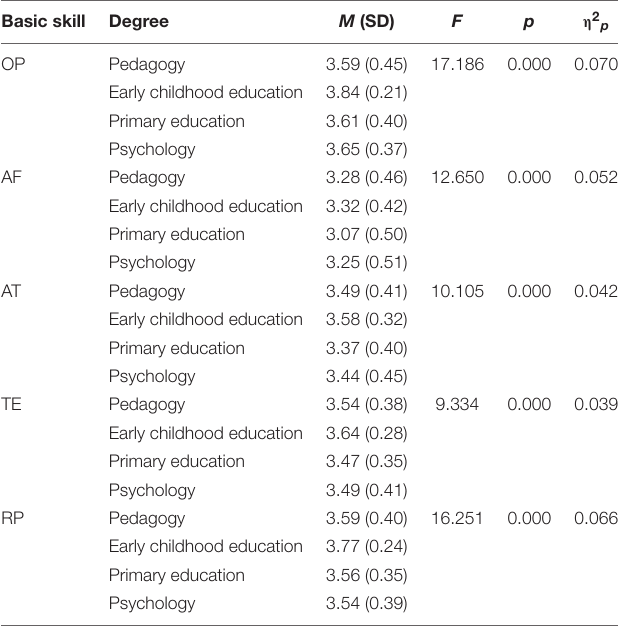
TABLE 3 | One-way Analysis of Variance